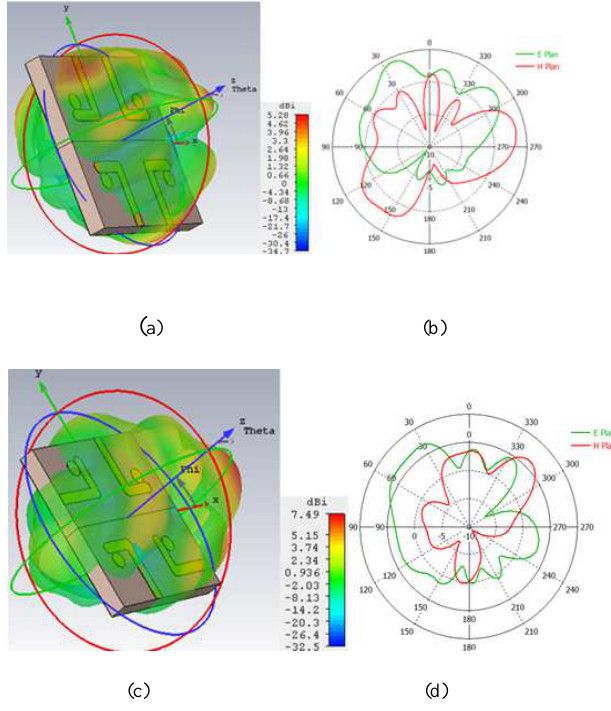
Fig9. Simulated Sij result of the proposed MIMO 2X2 antenna vs. Frequency; (a) the first MIMO antenna model and (b) of the second MIMO antenna model.